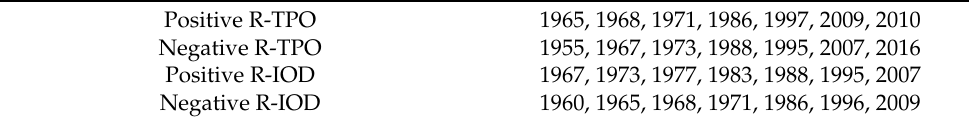
Table 1. Selected years of the positive and negative R-TPO and R-IOD events. Figure 2. Spatial loading pattern and principal component (PC) time series of first EOF mode the interannual SST anomalies during the southern springs of the 1951–2016 period for the: ( a ) tropical Pacific Ocean; ( b ) PC for the tropical Pacific loading pattern; ( c ) tropical Indian Ocean; and ( d ) PC for the tropical Indian Ocean loading pattern. Continuous contours encompass the significant cor- relations at a 95% confidence level using the Student’s t -test.